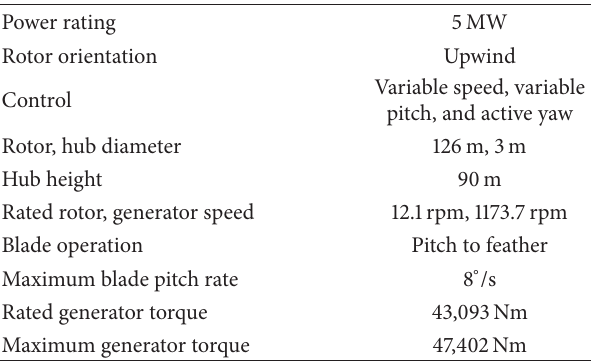
Table 1: NREL 5 MW turbine model properties.